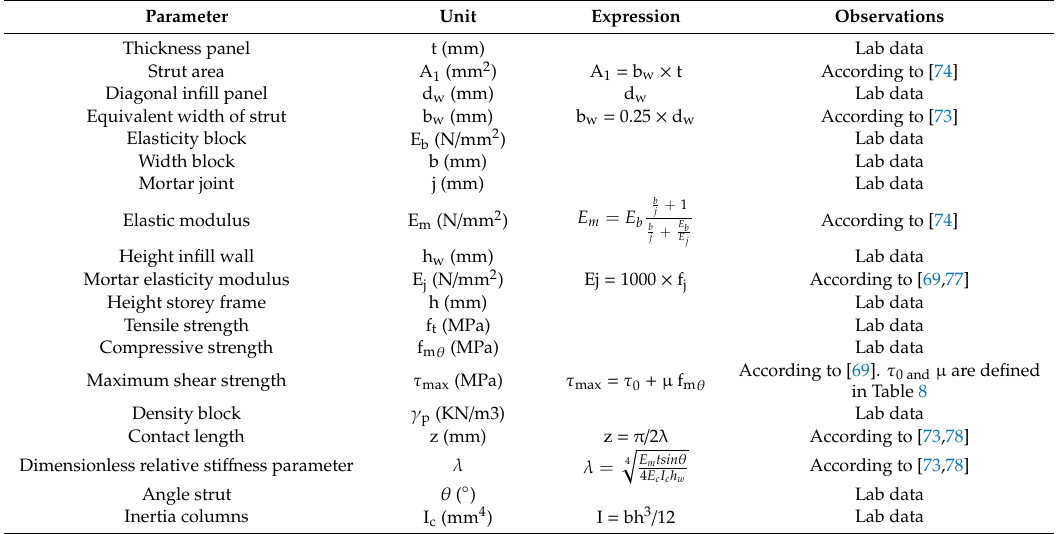
Table 6. Geometric and mechanic parameters obtained in the laboratory.